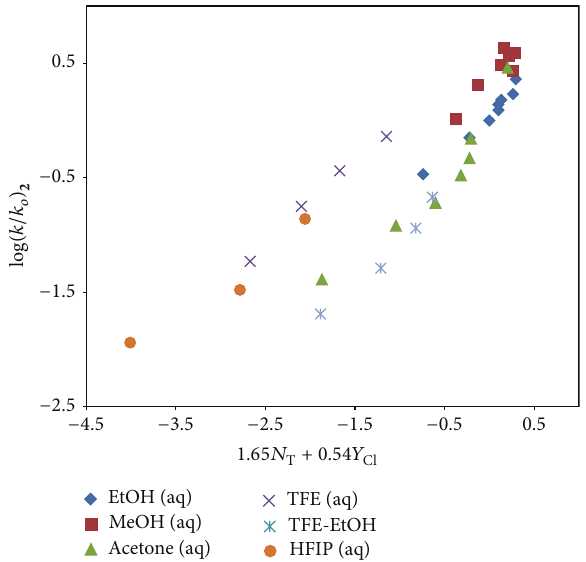
Figure 5: The plot of log (𝑘/𝑘 𝑜 ) for 9-fluorenylmethyl chloroformate + 0.54𝑌 in the thirty-three pure and binary ( 2 ) against 1.65𝑁 T Cl solvents studied. The points for TFE-H 2 O and HFIP-H 2 O are not included in the correlation. They are added to show the extent of their deviation from the